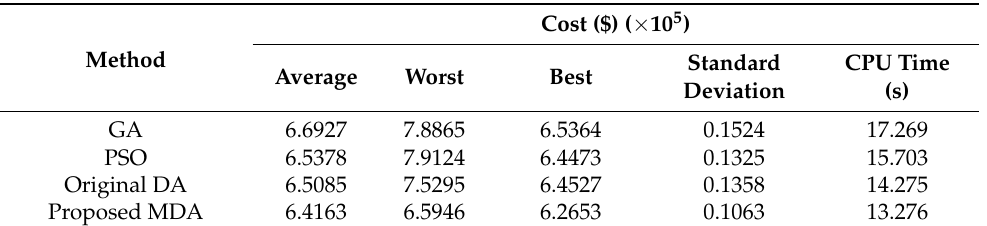
Table 7. Robustness and searching features of different optimization algorithms: minimizing total microgrid cost over 20 trails for 24 h of operation.